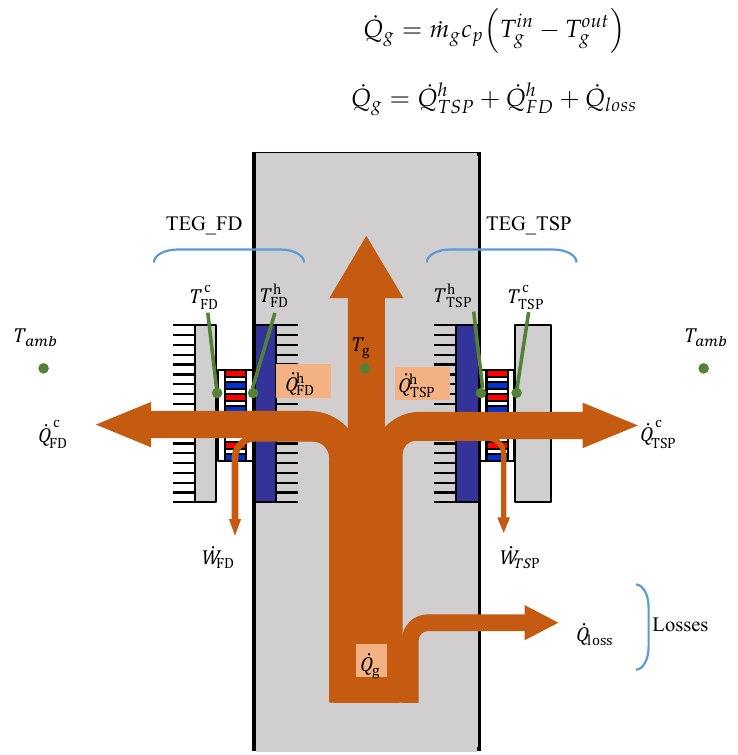
Figure 1. Scheme of the methodology to estimate thermal resistances and heat